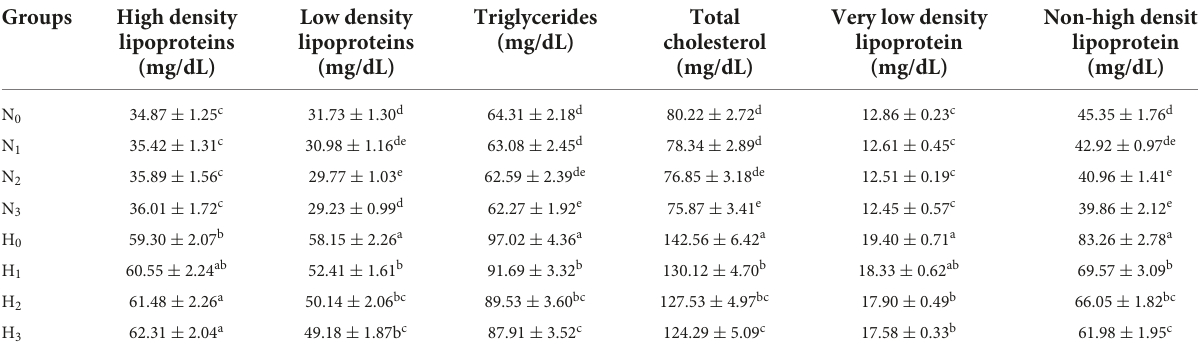
TABLE 3 Serum lipid profile of rats treated with different curcumin-enriched diets.